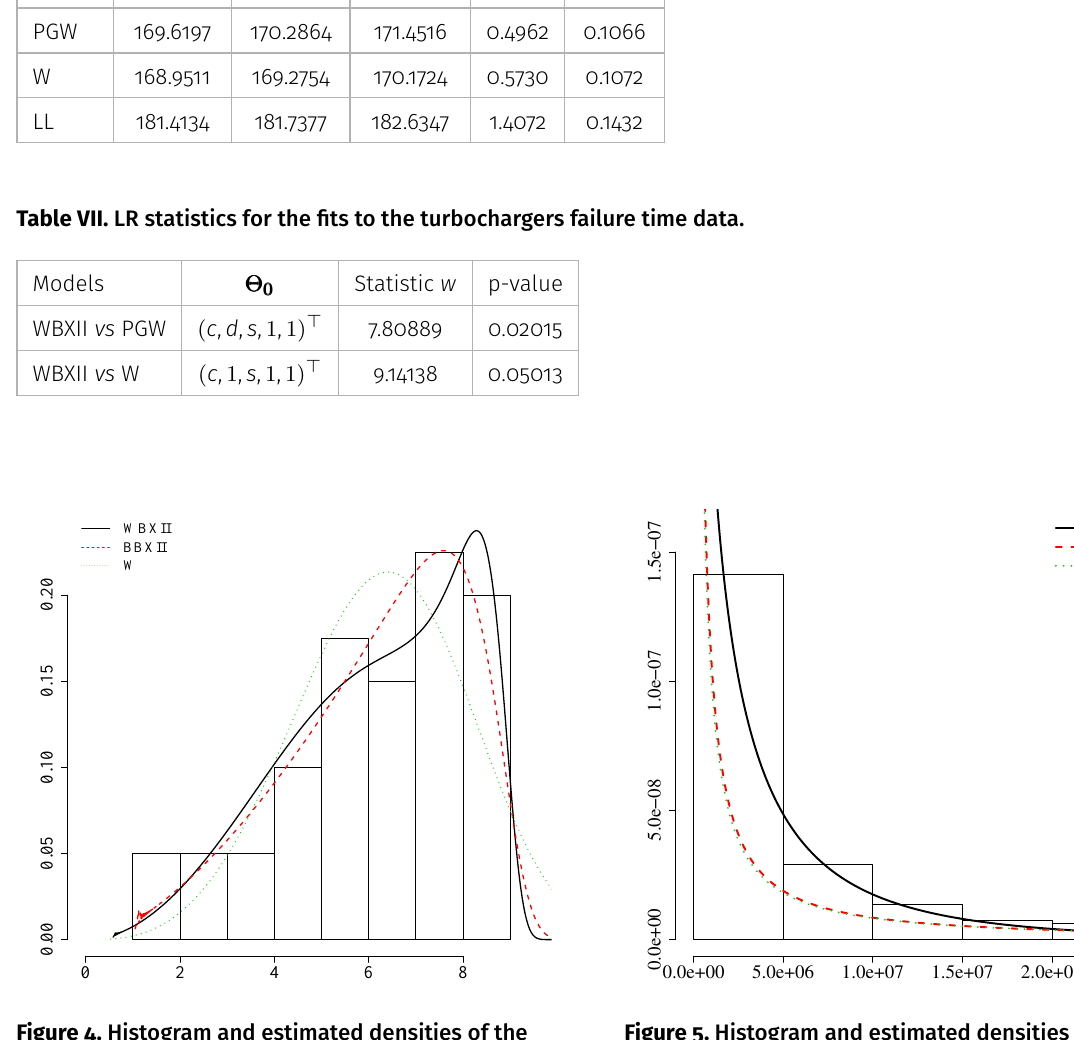
Figure 4. Histogram and estimated densities of the WBXII, BBXII and W models for the turbochargers failure time data.